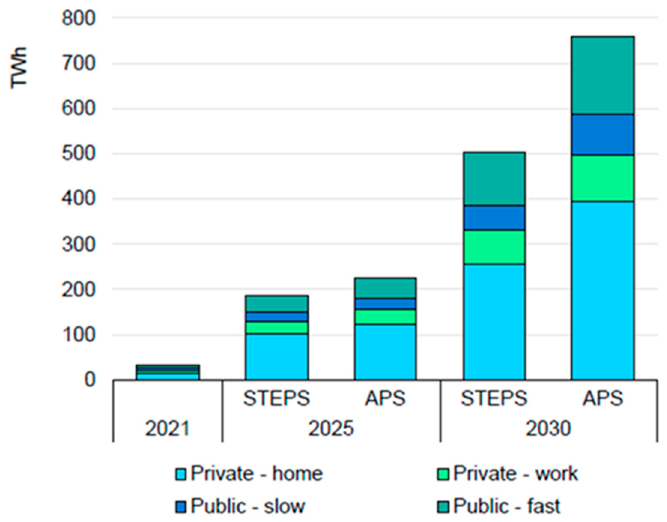
Figure 2. The electric energy required for charging EVs in the New Policies Scenario [7]. STEPS Stated Policies Scenario; APS Announced Pledges Scenario.